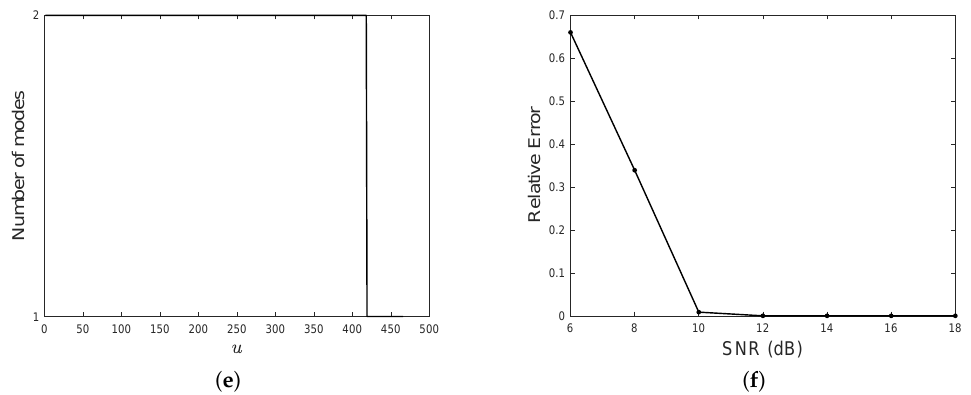
Figure 11. ( a ) Two-component FM signal embedded with additive white gaussian (AWG) noise, Signal to Noise Ratio (SNR) = 10 dB. ( b ) Spectrogram of ( a ), s = 46. ( c ) Optimal threshold provided by Minimum Description Length (MDL) functional minimization, according to Equation (18). ( d ) Binary map derived from ( b ), with removed black holes. ( e ) Estimated number of modes. ( f ) Relative counting error against SNR.